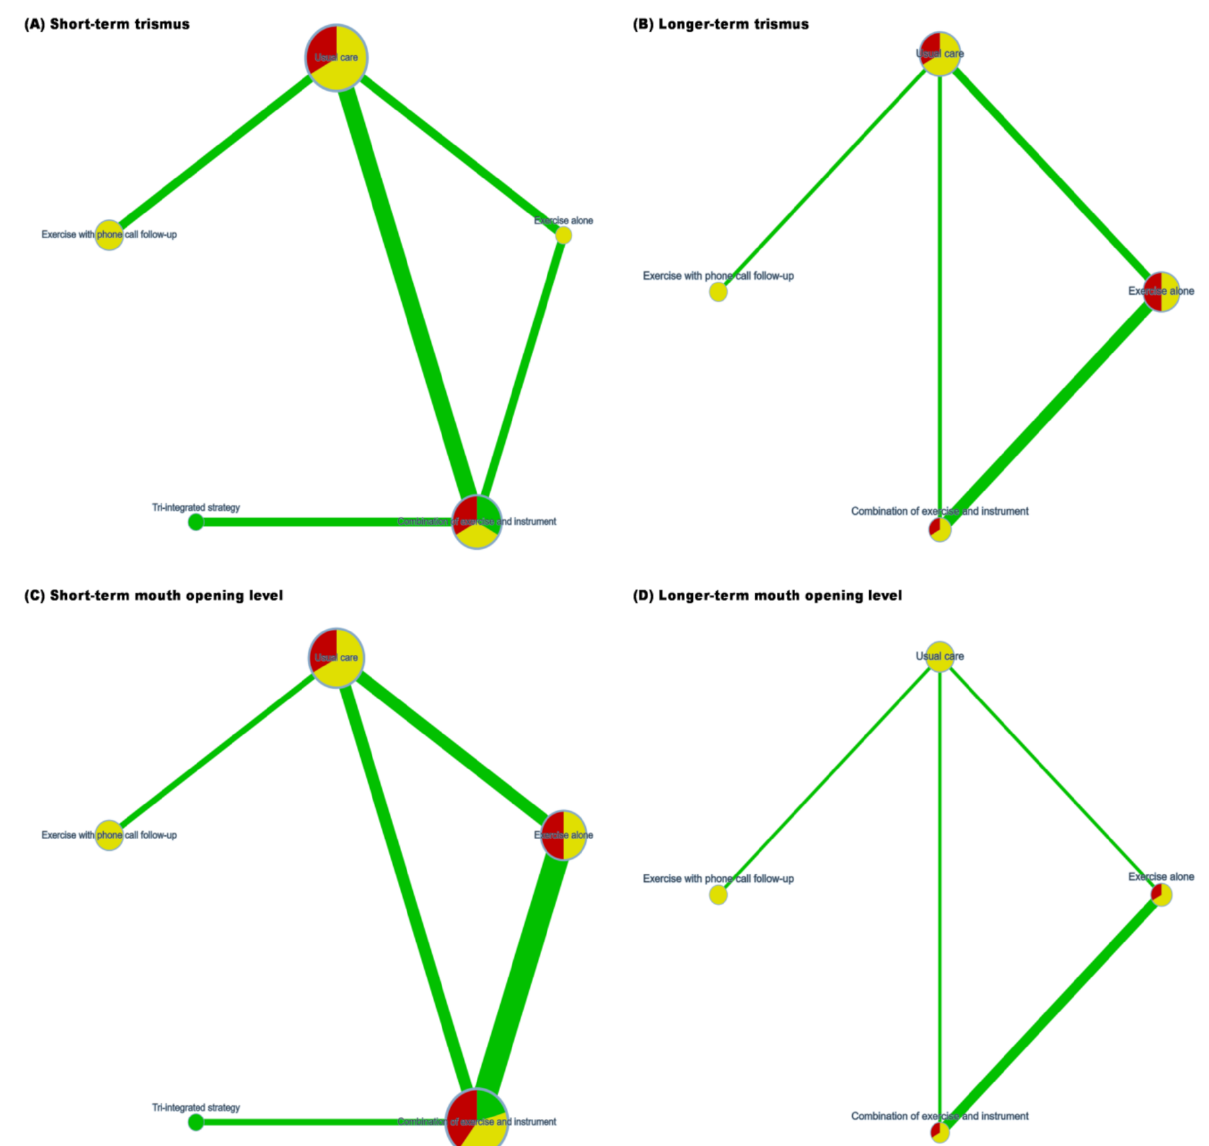
Figure 2. Network geometry of the consistency model for ( A ) short-term trismus, ( B ) longer-term trismus, ( C ) short-term mouth opening level, and ( D ) longer-term mouth opening